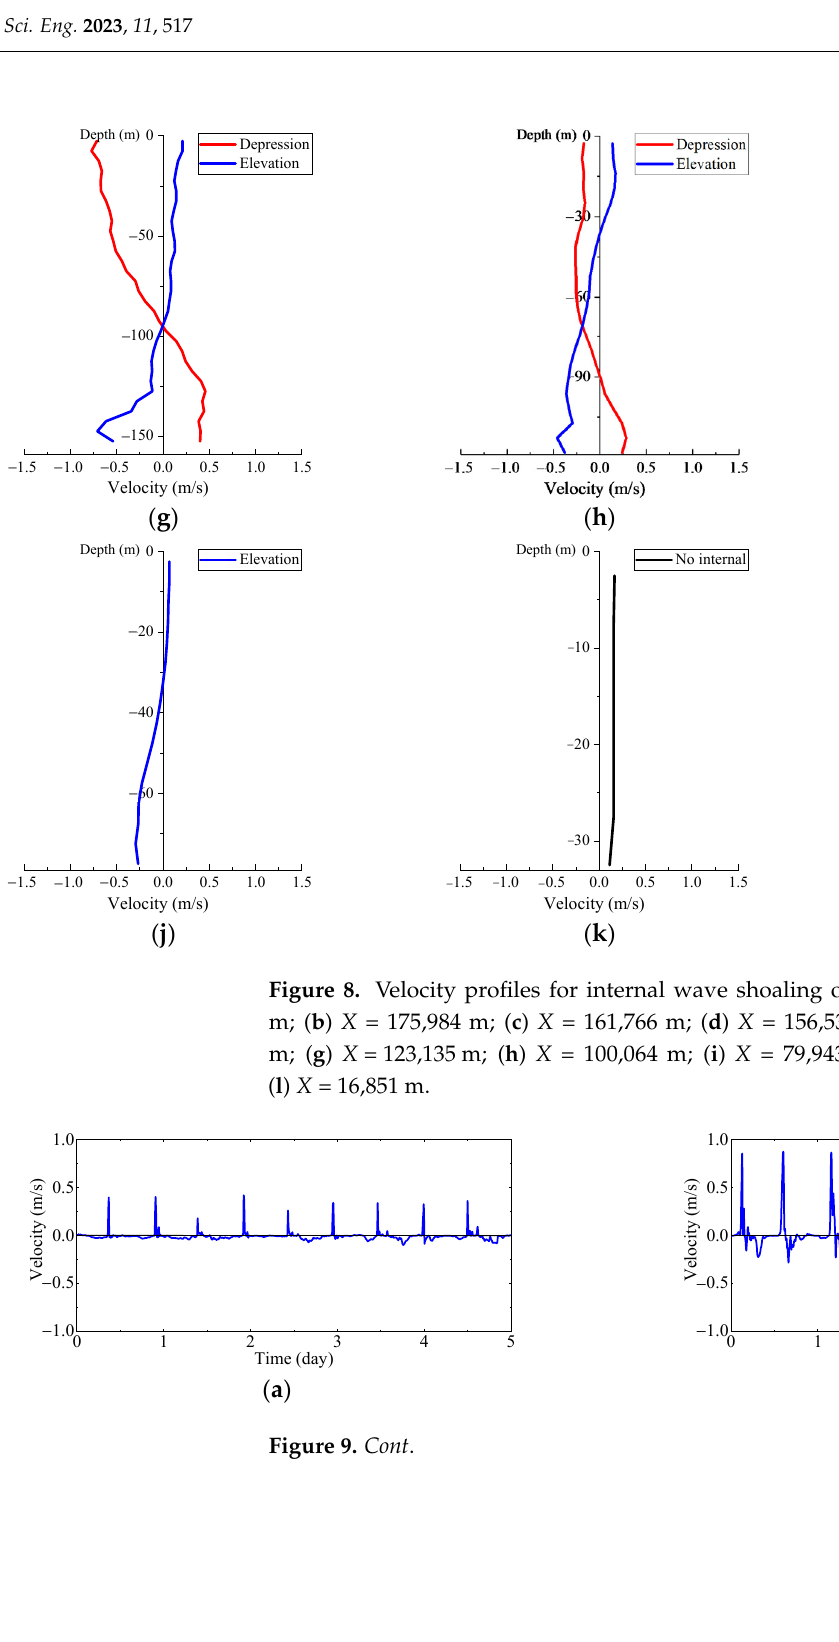
Figure 9. Time series of bottom current for internal wave shoaling on the continental slope, ( a ) de- pression mode; ( b ) depression dominant mode; ( c ) equivalent mode; ( d ) elevation dominant mode; ( e ) elevation mode and ( f ) tidal mode. 5. Sediment Transport on the Continental Slope Induced by Internal Waves The different types of bottom current velocities along the continental slope resulted in different characteristics of sediment transport. Here, the bed shear stress and the bed- load transport were calculated further to investigate the general characteristics of sedi- ment movement on the continental slope of the northern SCS. 5.1. Bed Shear Stress We made two assumptions in the calculation of the bed shear stress along the con- tinental slope: (1) the sediment particle size of D 50 = 0.45 mm was set and unified along the continental slope of the northern SCS, which resulted in a unified critical shear stress of τ cr = 0.24 N/m 2 according to the empirical formula by Soulsby and Whitehouse [33]; (2) the bottom shear stress b τ was calculated by a logarithmic function: ( ) 2 2 0 ln / b u u z z ρκ τ = (19) where κ= 0.41 is the Karman constant. In this study, the velocity at the vertical grid that was nearest to the seabed was used to compute the bed shear stress. The values of z were dependent on the thickness of the horizontal layer close to the seabed. The rough- ness length of the bottom z 0 (= d 50 /12) was taken as 3.8 × 10 − 5 mm in this study. As shown in Figure 10, the bottom current velocities at 16 positions along cross-section P1 (see Figure 1) from deep to shallow water were selected, and the corre-